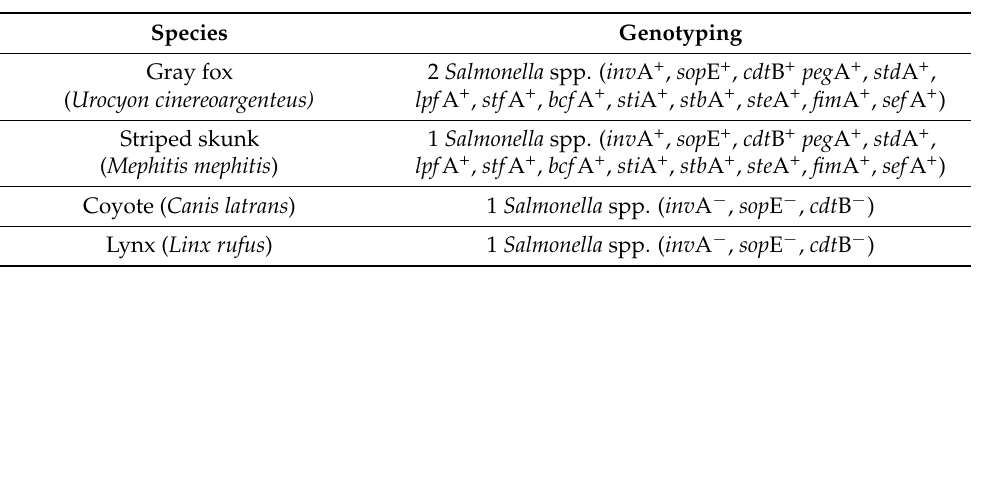
Table 2. Characteristics of Salmonella spp. strains isolated from